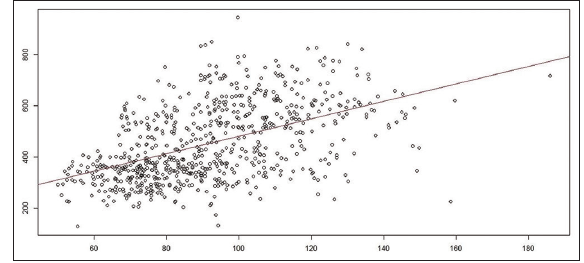
FIGURE 5. Regression line showing the tendency of the linear regression results of the maximum hand grip strength (Y-axis) unit is in Newton and the body weight (X-axis) unit is in kilograms.